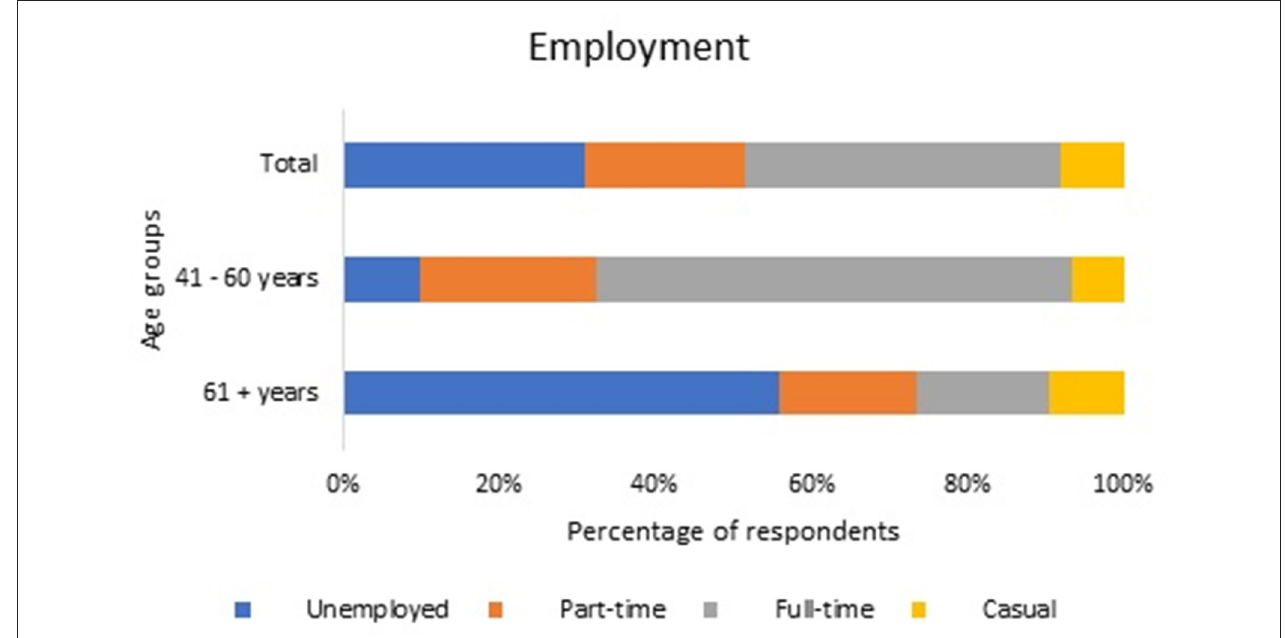
FIGURE 1 | The percentage of respondents who were either unemployed, part-time, full-time, or casually employed prior to the COVID-19